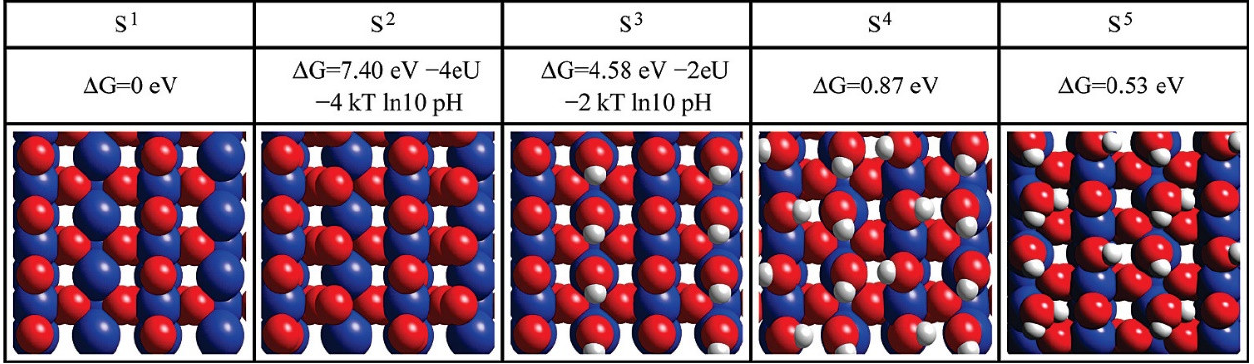
Figure 3. The structures of various surfaces studied. S 1 , S 2 , S 3 , S 4 , and S 5 represent the surface with oxygen occupying all bridge sites occupied by oxygen, the surface with totally covered O*, the surface with bridge sites occupied oxygen and CUS sites occupied by HO*, the surface totally covered by HO*, and the surface with alternating deprotonated non-deprotonated adsorbed water. The blue, red, and white spheres represent metal ions, oxygen, and hydrogen, respectively. (Reprinted from ref. [49] with permission from the American Chemical Society. Copyright © 2008, American Chemical Society).